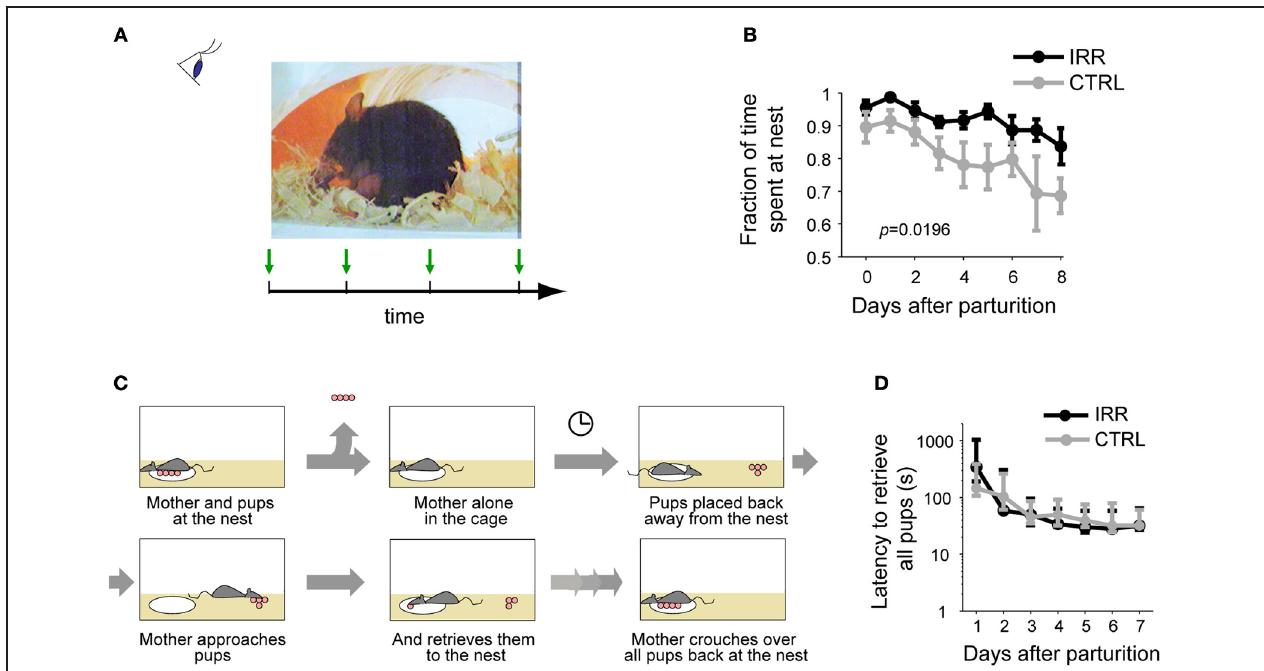
(Feierstein et al., 2010). (C) Schematic of pup retrieval. Retrieval behavior was tested daily, starting the day after parturition (P1). (D) Latency to finish retrieval (the fourth pup brought back to the nest) was identical in CTRL and IRR females. Data are shown as median latencies, in logarithmic scale; error bars represent 25th and 75th